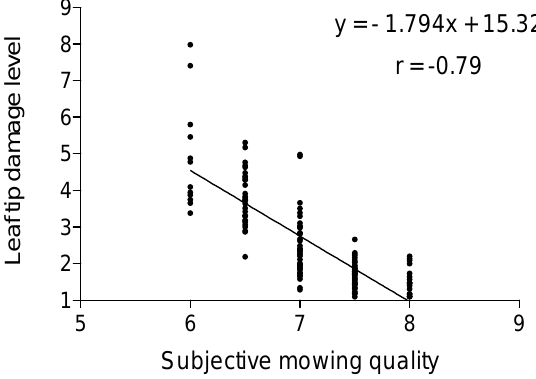
Figure 8. Tall fescue leaf tip damage level (Equation (1)) and subjective mowing quality (1 = poor, 9 = excellent) correlation and Pearson’s correlation coefficient (r). All replicates are reported.